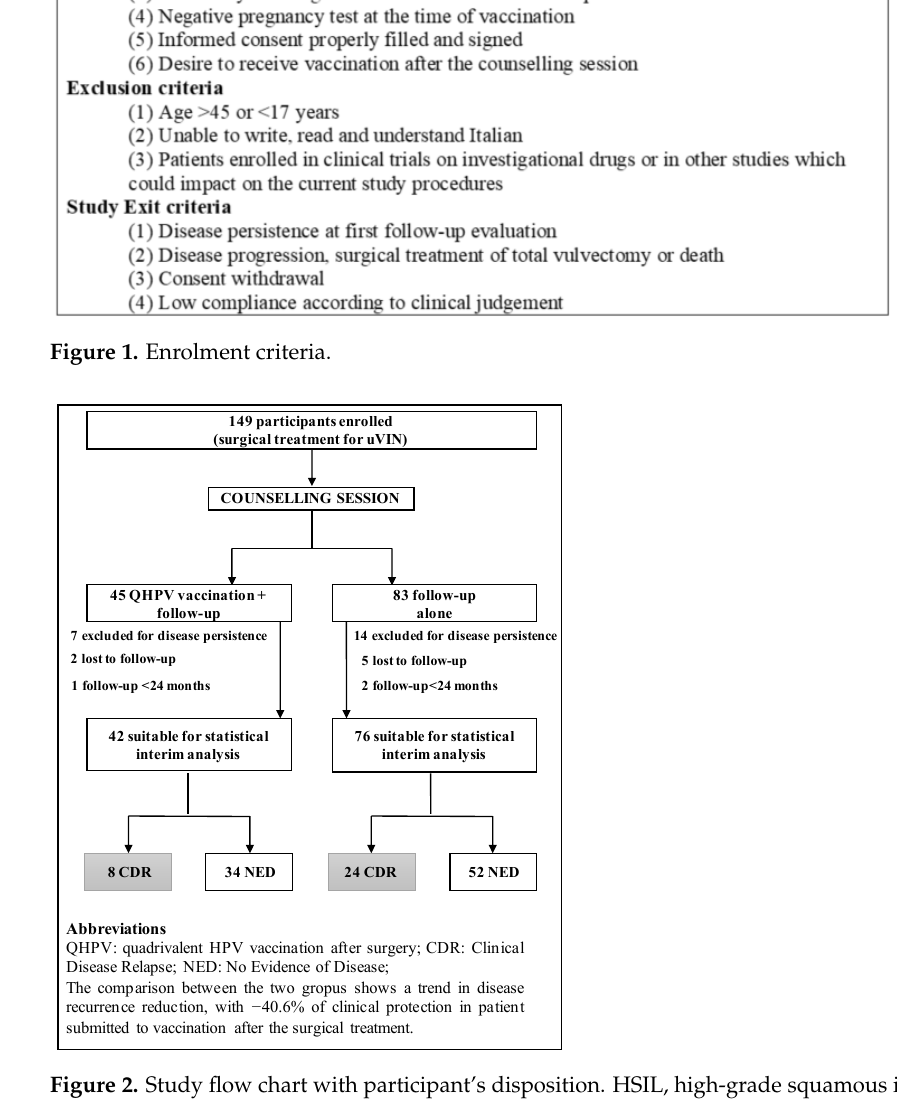
Figure 2. Study flow chart with participant’s disposition. HSIL, high-grade squamous intraepithelial lesions.